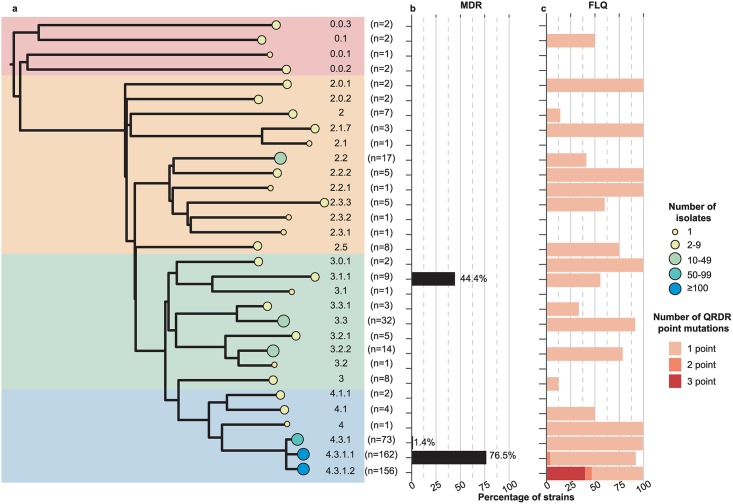
Membership of S. Typhi by genotypes and association with AMR.a) Population framework tree of the S. Typhi genotypes sequenced at PHE. Background shading indicates the primary clades. Tree tips indicate individual genotypes assigned by GenoTyphi; tip sizes and colours indicate number of isolates belonging to each genotype, these values (n) are also printed to the right. b) Frequency of MDR for each genotype (defined based on presence of AMR genes encoding resistance to the first line drugs ampicillin, trimethoprim-sulfamethoxazole, or chloramphenicol). c) Frequency of QRDR mutations by genotype.